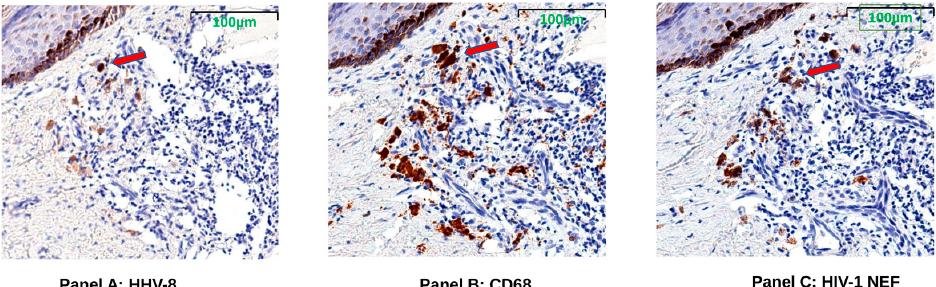
Figure 3. Representative images (K10) showing HHV-8 LANA (Panel A ), CD68 (Panel B ), and HIV-1 Nef proteins (Panel C ). Sequential tissue sections were taken from post-ART treatment Kaposi’s Sarcoma (KS) skin tumor biopsy of subject K10 for imaging with single-color immunohistochemistry (IHC) staining. Brown color indicates antibody binds to specific protein. Red arrows indicate a representative area where HIV-1 Nef and CD68, a tumor-associated macrophage marker, localized in the HHV-8-positive KS tumor region just under the margin of the epidermis (darkly pigmented cells near top left of